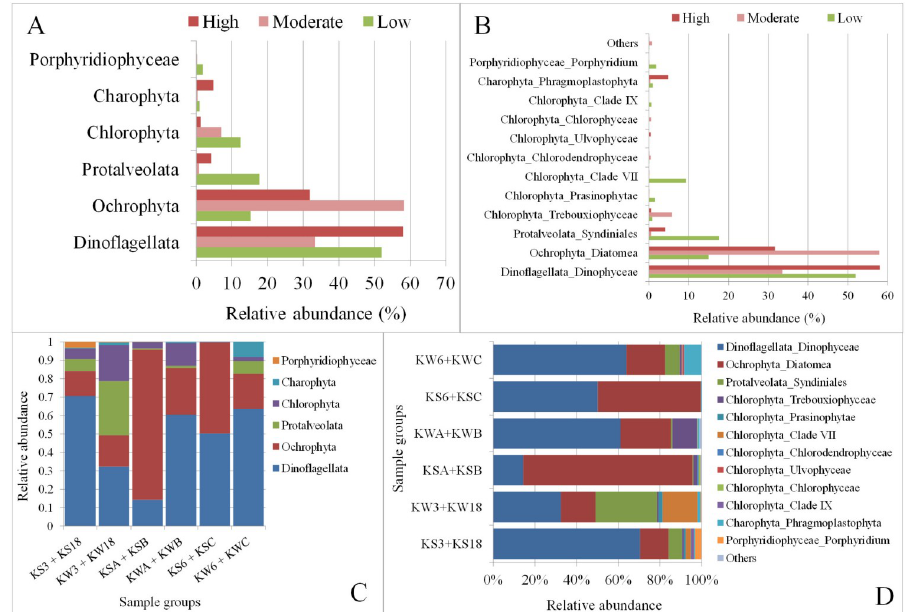
Fig 6. Marine phytoplankton diversity across different sampling stations in Kuwait Bay grouped by degree of anthropogenic activity. A and B: Phytoplankton communities in samples based on anthropogenic activity; C and D: Phytoplankton communities in samples based on anthropogenic activity and season. Descriptions of the sample groups in C & D are as follows: KS3 + KS18: samples collected from stations with low anthropogenic activity in the summer; KW3 + KW18: Samples collected from stations with low anthropogenic activity in the winter; KSA + KSB: Samples collected from stations with moderate anthropogenic activity in the summer; KWA + KWB: Samples collected from stations with moderate anthropogenic activity in the winter; KS6 + KSC: Samples collected from stations with high anthropogenic activity in the summer; KW6 + KWC: Samples collected from stations with high anthropogenic activity in the winter.